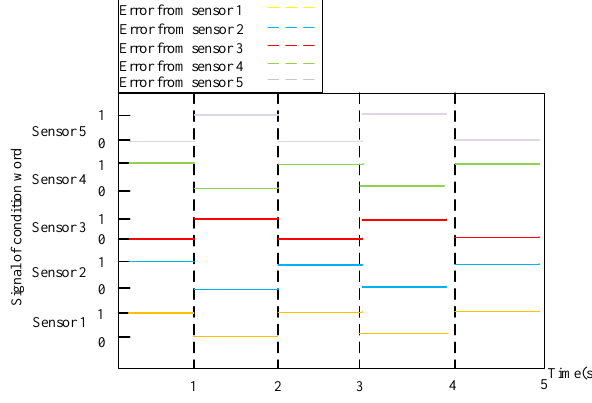
Figure 10. ECWs coded as system